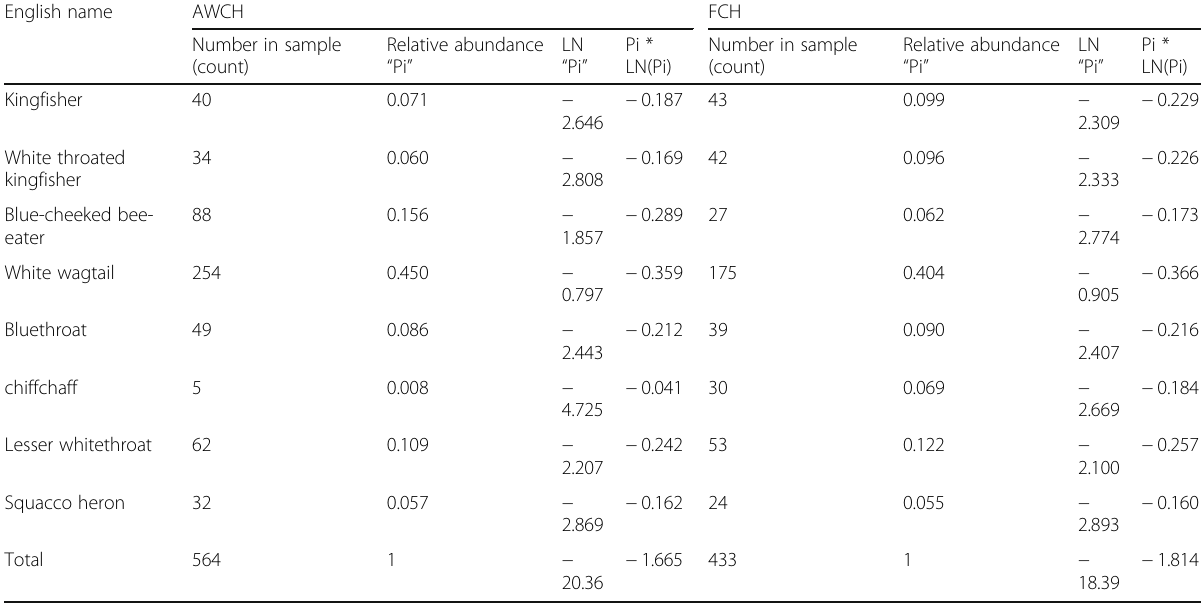
Table 3 Relative abundance of Migratory wild bird species observed at Sharkia